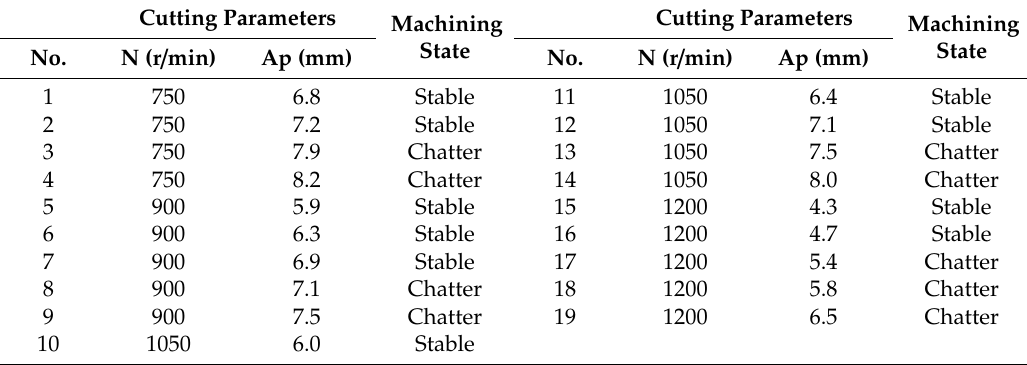
Figure 9. SLD, X-experimental stable, O-experimental unstable.